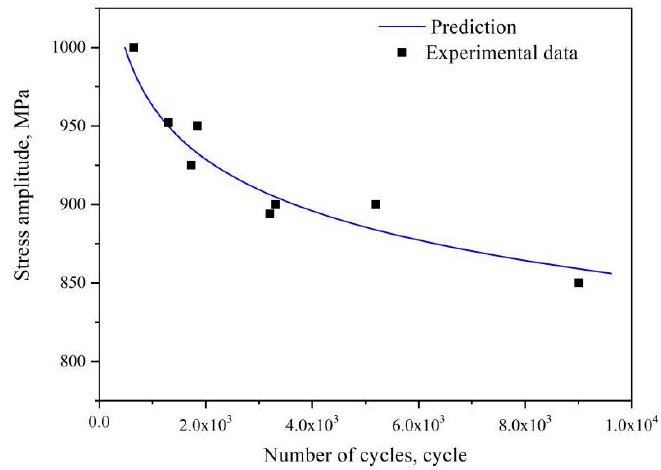
Figure 14 . The relationship between fatigue damage and plastic accumulation during low cycle fatigue under strain amplitude of 0.7%.